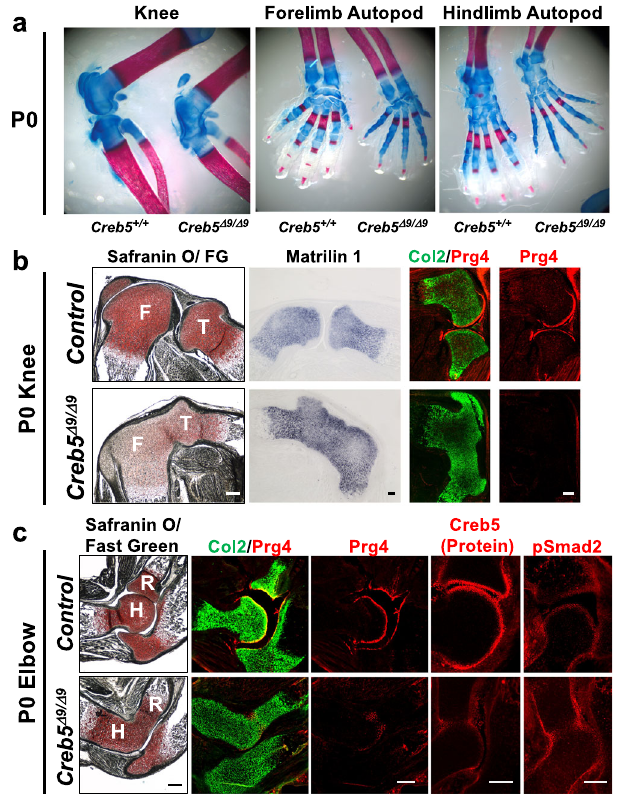
Fig. 3 | Creb5 is necessary for the formation of many synovial joints. a Alcian Blue/Alizarin Red staining of the knees and autopods of P0 Creb5 Δ 9/ Δ 9 mice or their WT littermates. Gene expression assayed by FISH and immunocytochemistry for Creb5 and carboxy-terminal phosphorylated Smad2 (pSmad2) in sections of the knees ( b ) and elbows ( c ) of P0 Creb5 Δ 9/ Δ 9 mice or their control littermates. Parallel sections were stained with Safranin O/Fast Green (FG). Femur (F), Tibia (T), Humerus(H)andRadius(R)areindicated.Similarresultswereobtainedineither14 ( a ), 4 ( b ) or 2 ( c ) independent biological repeats. Scale bar equals 200